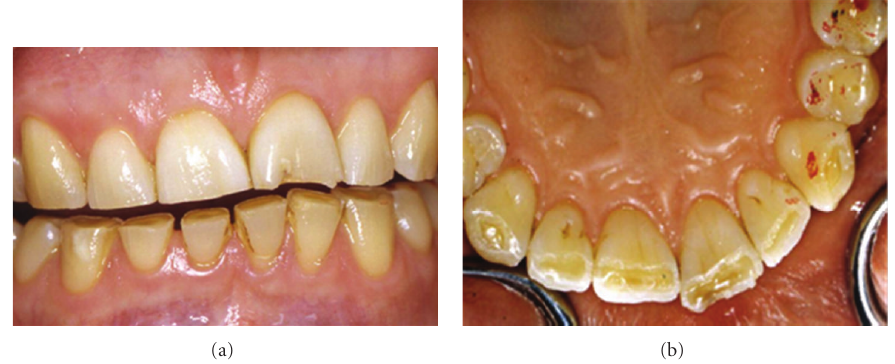
Figure 3: Photographs of a patient with attritional wear of the maxillary and mandibular teeth.